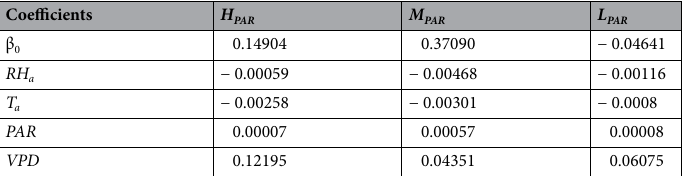
Table 5. Coefficients of the model (see Eq. 3) for the determination of V s of cacao trees using microclimatic variables under different radiation intensities as predictors. Types of AF are described in the methods section and in Fig. 2 . Microclimatic variables are: air relative humidity ( RH a ; %); air temperature ( T a ; °C); photosynthetically active radiation ( PAR ; µmol m −2 s −1 ); and vapor pressure deficit ( VPD ; kPa). Coefficient values were calculated using results in Table 4. β 0 is the